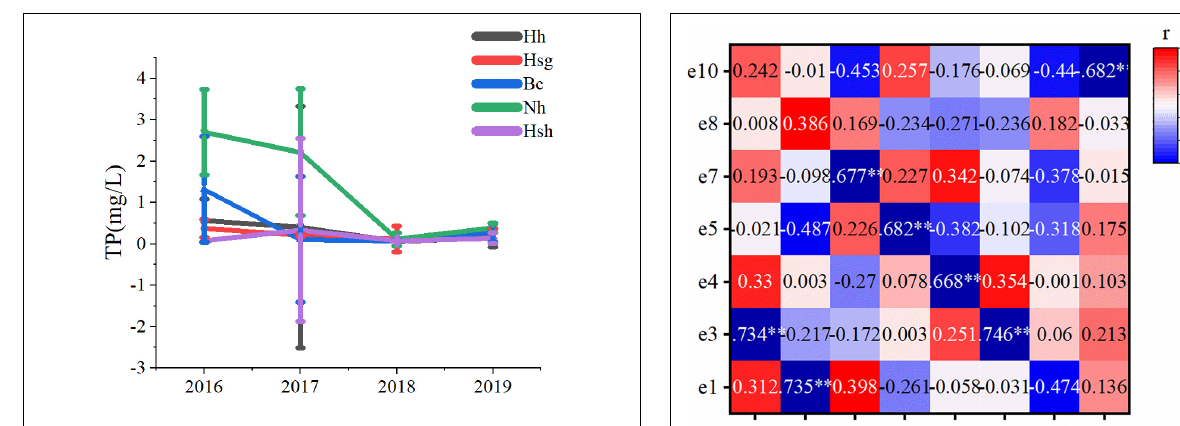
FIGURE 8 | Annual changes of eutrophication in Huangshui wetland. TP (Total Phosphorus), The unit of concentration is mg/L; Hh (Haihu Wetland); Hsg (Huoshaogou Wetland); Bc (Beichuan Wetland); Nh (Ninghu Wetland); Hsh (Huangshuihe Wetland).